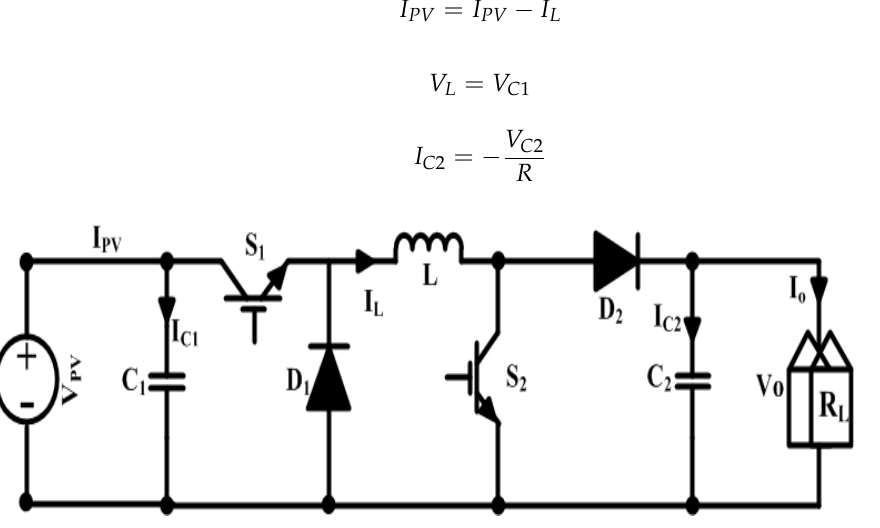
Figure 8. Non − inverting configuration of DC ‐ DC buck ‐ boost converter. Whereas in the second interval 𝑆 (cid:2869) and 𝑆 (cid:2870) are inactive and 𝐷 (cid:2869) and 𝐷 (cid:2870) are forward ‐ biased. Using Kirchhoff’s current and voltage law, we have: